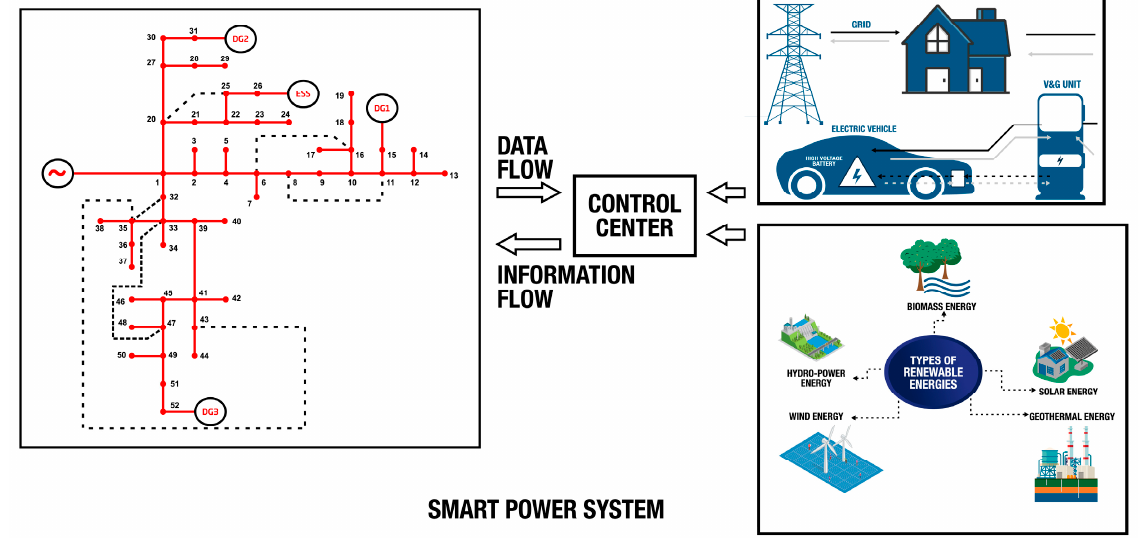
Figure 12. Smart power system in smart cities.